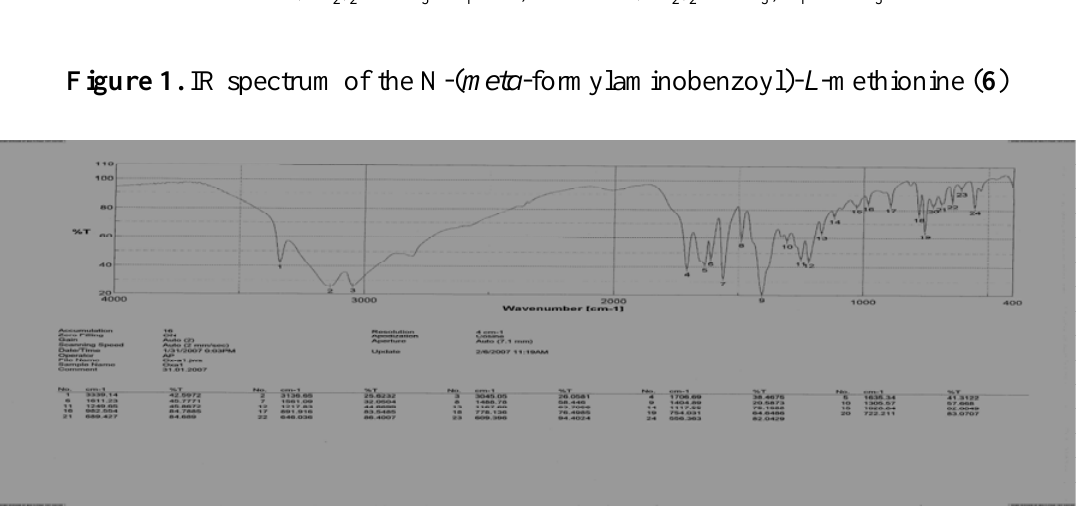
Figure 2. IR spectrum of 2-( meta -formylaminophenyl)-4-( β -methylthio- ethyl)- Δ 2 -oxazolin-5-one ( 12